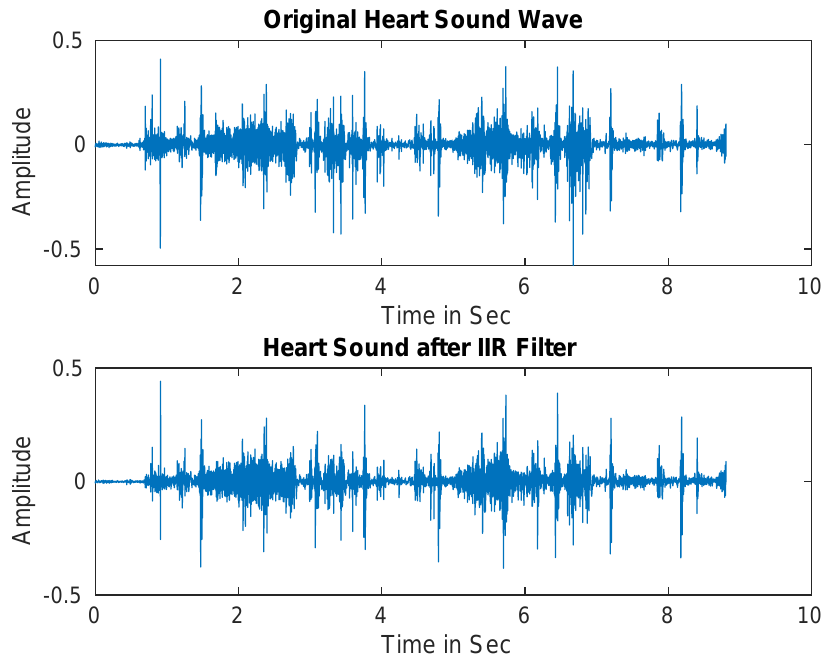
Figure 2. Heart sound signals after applying Infinite Impulse Response (IIR)